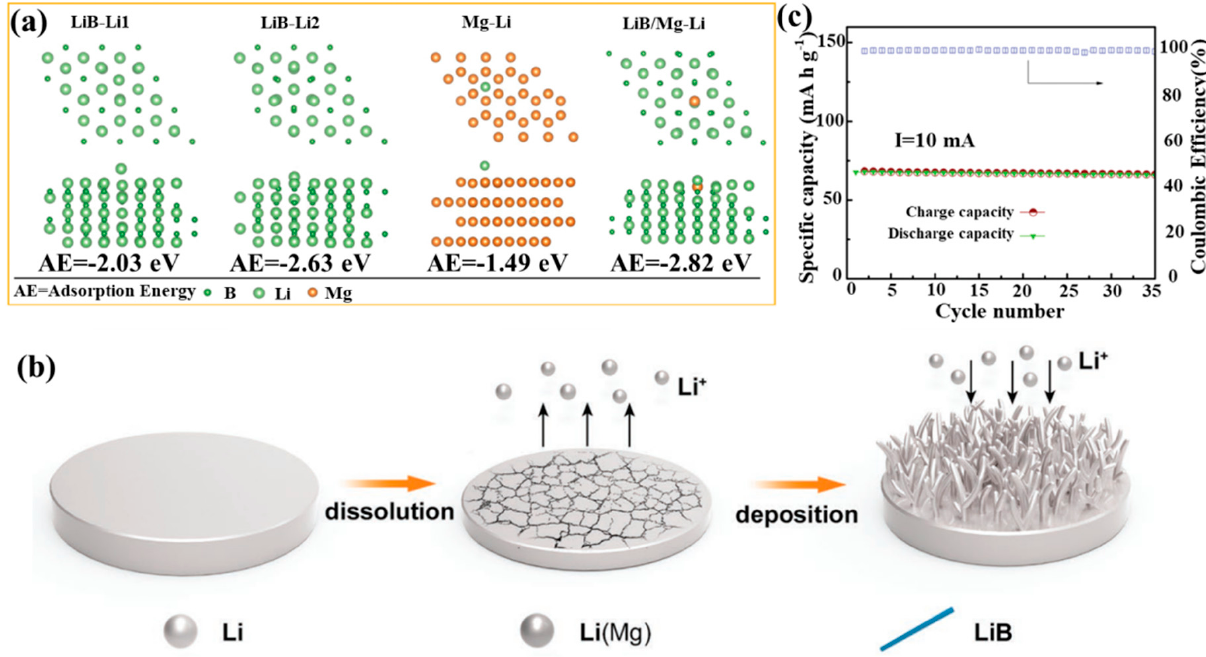
Figure 4. ( a ) Adsorption energies of one lithium atom on the surface of LiB, Mg, and LiB/Mg, respectively; ( b ) The stripping/plating process of lithium on LiB skeleton; ( c ) Pouch-type batteries using Li-B-Mg anode and LiCoO 2 cathode in the carbonate-based electrolyte [45]. Copyrights © 2022, WILEY-VCH.